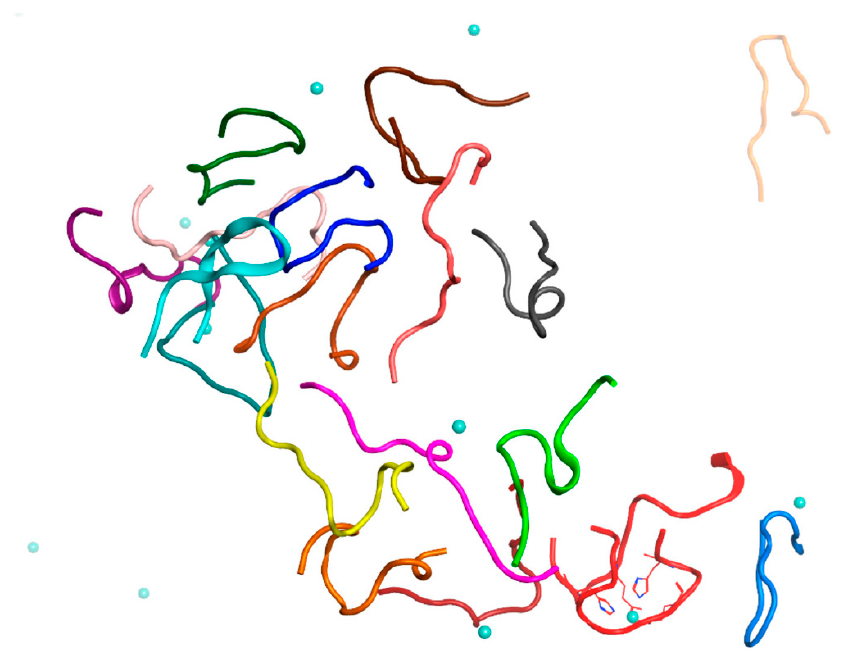
Figure 7. Results of 150 ns MD simulation of the Аβ 16 System 6 from Table 1 (C zn > C Аβ ). Box size is 15 nm. The Аβ 16 molecules are shown with different colors. Zinc coordinating side chains are shown. Zinc ions are highlighted in blue. The Аβ 16 dimer is colored red.